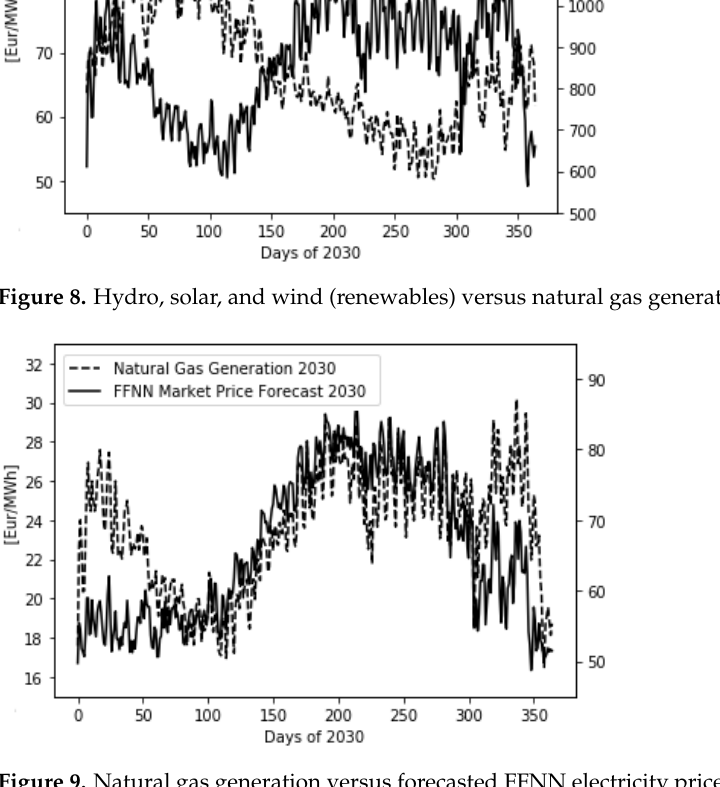
Figure 9. Natural gas generation versus forecasted FFNN electricity prices for 2030 in MIBEL.